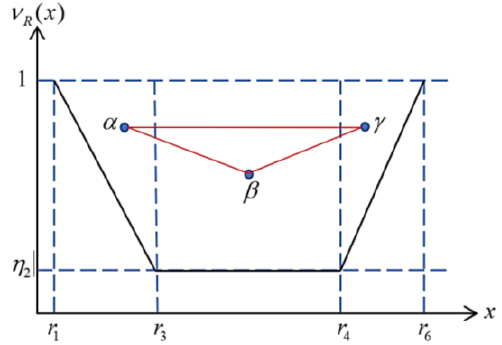
Fig. 5. The triangular plane is formed by connecting the sub-centroids of three areas of non-membership